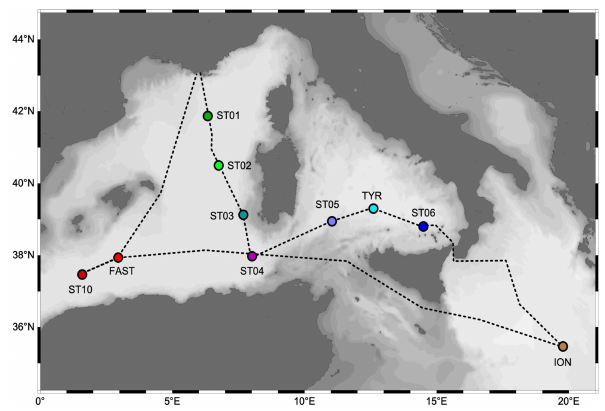
Figure 1. Sampling sites. Color codes on dots correspond to the plots in Fig.